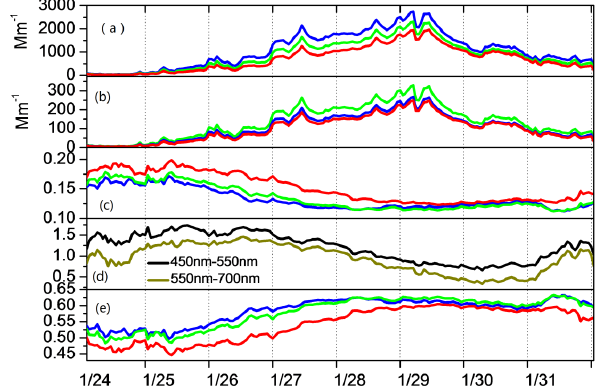
Figure 4. Time series of (a) scattering coefficients σ sp , (b) backscattering coefficients σ bsp , (c) backscattering ratios b λ , (e) asymmetry parameter g λ at wavelengths of 450nm (blue), 550nm (green) and 700nm (red) (d) scattering Ångström exponent (Å sp ) from 450–550nm (black) and 550–700nm (brown).